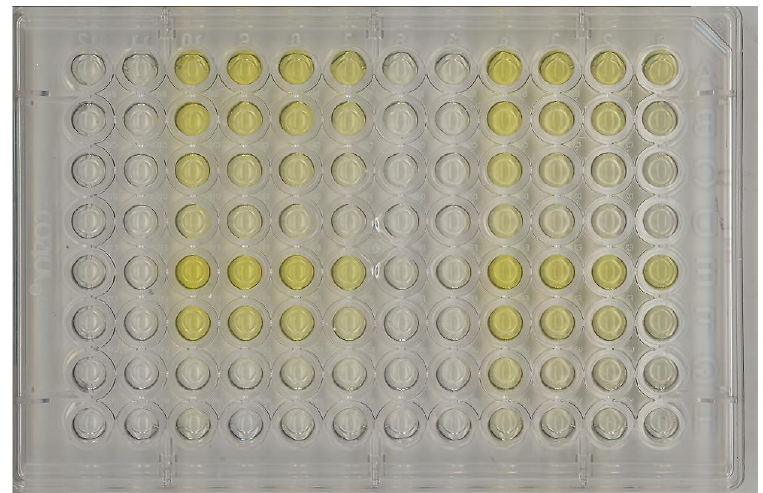
Figure 2. Scanned image of an ELISA plate.